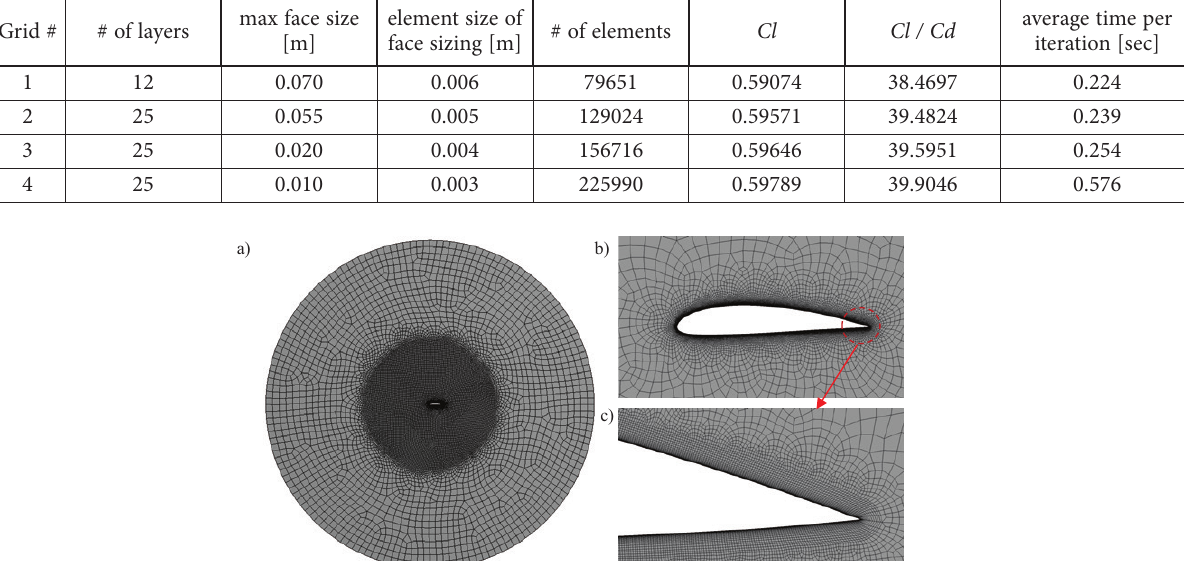
Figure 3. Mesh details around the airfoil: a) full domain b) magnified view of the